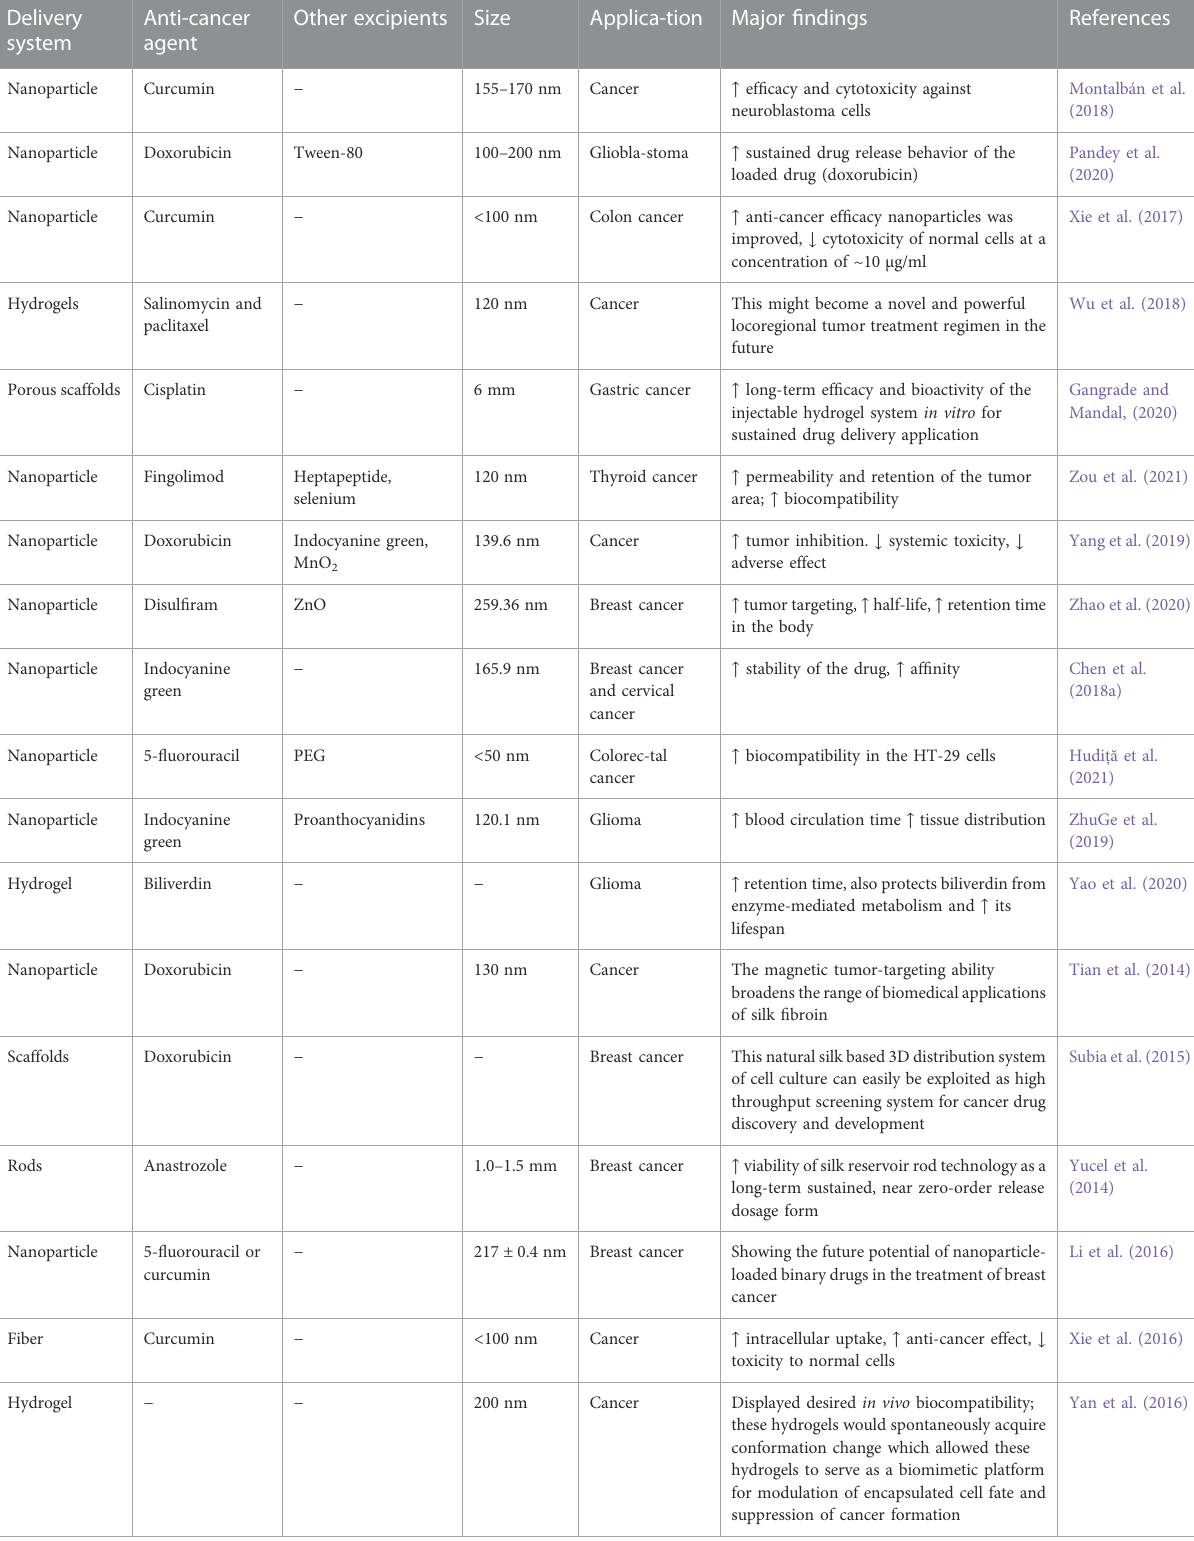
TABLE 4 The related research on silk fi broin as a carrier for drug delivery systems in